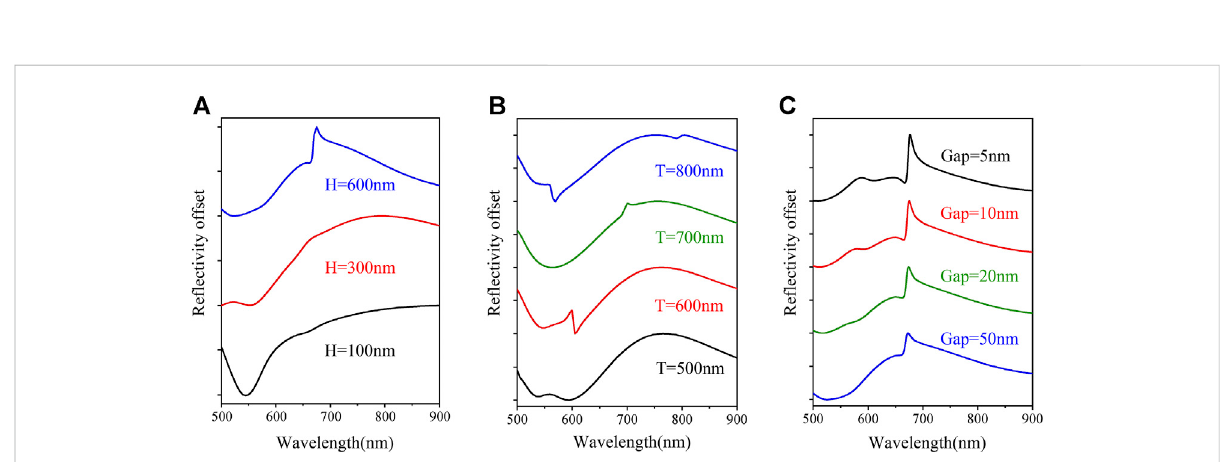
FIGURE 5 Numerically simulated re fl ection spectra of trimer Au nano fi nger arrays with different geometric structure parameters at normal incidence. (A) Simulated re fl ection spectra of nano fi ngers with different heights, and the period T and gap size are set as 670 nm and 130 nm, respectively. (B) Simulatedre fl ectionspectraofnano fi ngerswithdifferentlatticeconstants,andtheheight H andgapsizearesetas600 nmand130 nm,respectively. (C) Simulatedre fl ectionspectraofnano fi ngerswithdifferentgapsizesofadjacentnano fi ngers,andtheperiod T andheight H aresetas670 nm and 600 nm,